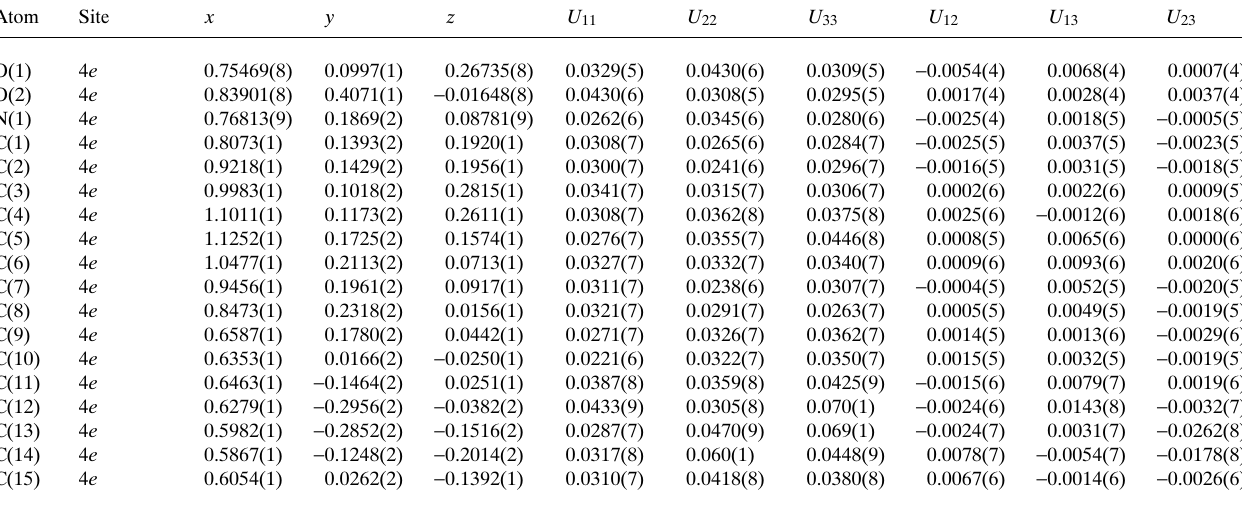
Table 3. Atomic coordinates and displacement parameters (in Å 2 )